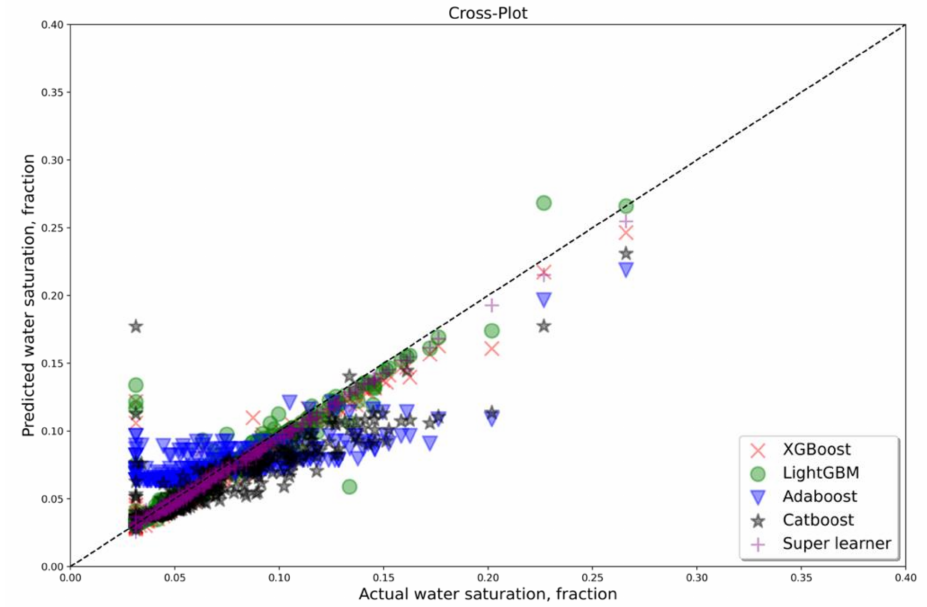
Figure A3. Cross plot for water saturation prediction results by different algorithms (Well 3). Appendix B. Cross Plots for All Wells, Which Were Considered as Testing for Dataset